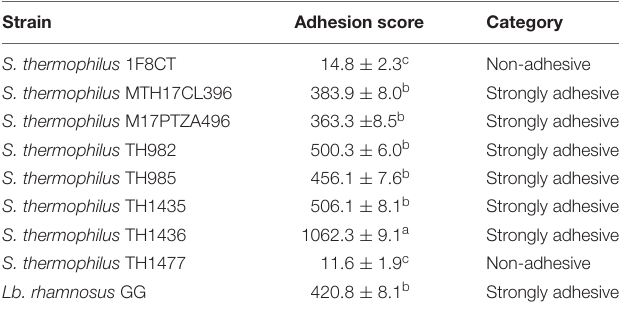
TABLE 3 | Adhesion potential of bacterial strains.